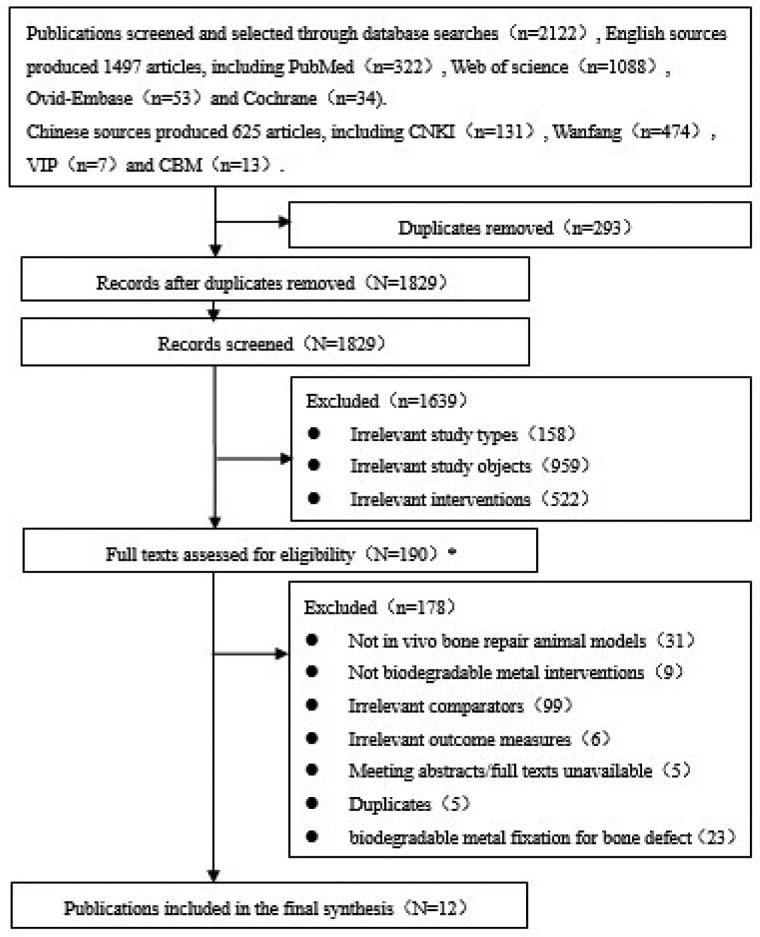
Study screening and selection process